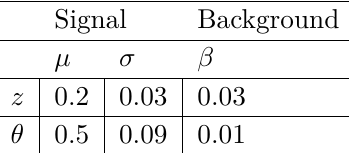
Table 1. Parameters used to generate toy model distributions. µ and σ are the parameters for a